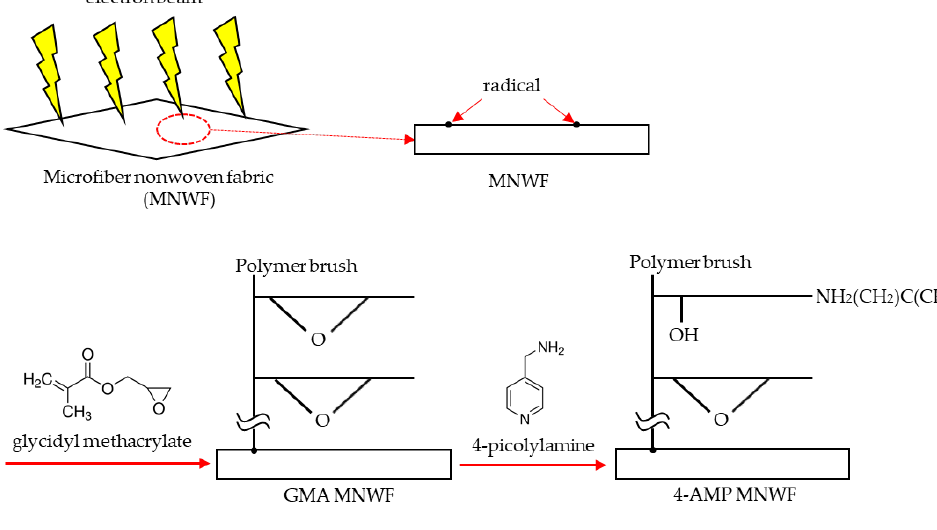
Figure 2. Introduction of 4-AMF into GMA MNWF.